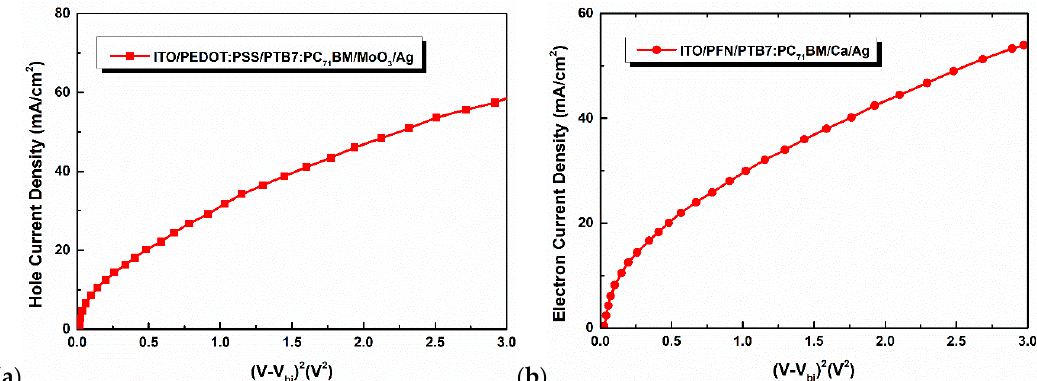
Figure 12. ( a ) Hole current density-( V-V bi ) 2 graph obtained for a bulk heterojunction organic solar cell based on PTB7:PC 71 BM. ( b ) Electron current density-( V-V bi ) 2 graph obtained for a bulk heterojunction organic solar cell based on PTB7:PC 71 BM. The hole mobility and electron mobility values are calculated by adding the respective J SC values to the Mott–Gurney equation (Equation (3)) and solving for μ .